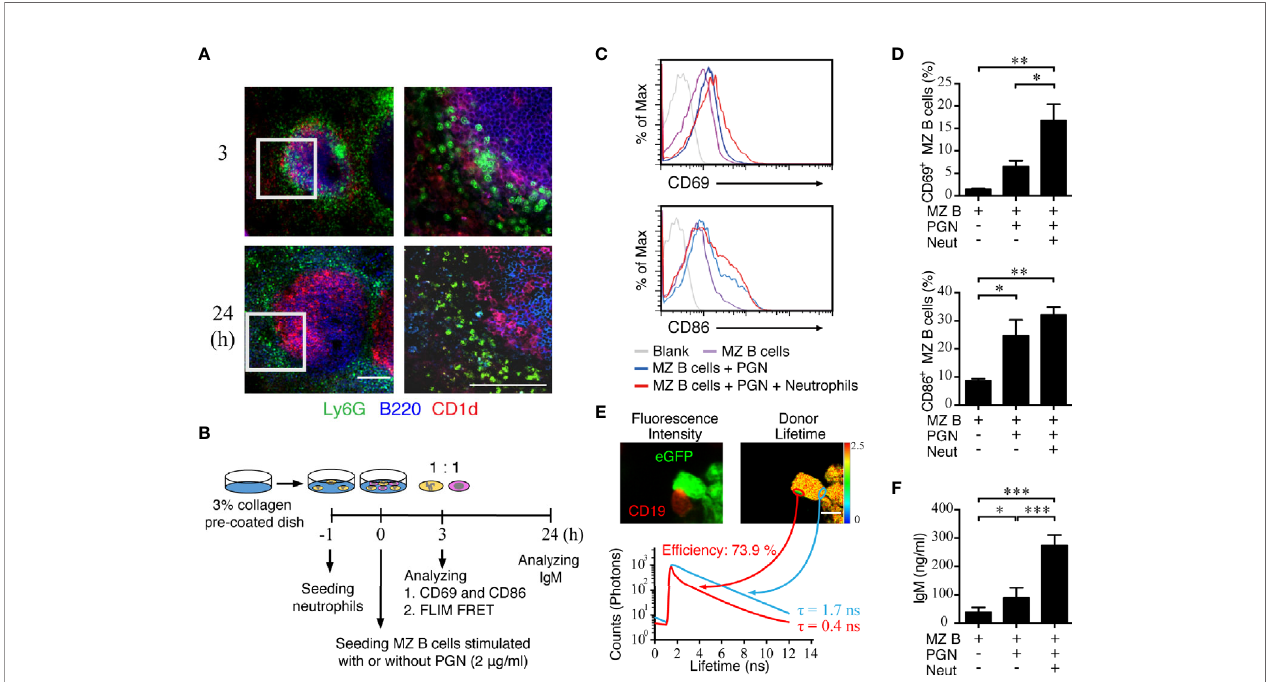
FIGURE 5 | Activation of MZ B cells and IgM production after interaction with neutrophils in S. aureus infection. (A) Confocal microscopy images showing the neutrophils and MZ B cells at 3 h or 24 h after systemic infection with S. aureus (2.5 × 10 6 CFU) in WT mice. Right panels present enlarged images from the boxed areas in the left panels. Scale bar = 100 µm. (B) Schematic diagram showing the experimental design of MZ B cell and neutrophil co-culture experiments. (C) Flow cytometric analysis showing the levels of CD69 (upper panel) and CD86 (lower panel) expression on MZ B cells co-cultured with neutrophils at 3 h after stimulation with PGN (2 µg/ml). (D) Statistical analysis of the percentages of CD69 + (upper panel) or CD86 + (lower panel) MZ B cells co-cultured with neutrophils (Neut) with or without PGN stimulation. (E) The interaction of neutrophils and MZ B cells detected by FLIM FRET analysis. Neutrophils were puri fi ed from LysM-eGFP mice. Sorted MZ B cells were labeled with anti-CD19 primary antibody and Alexa Fluor 546 secondary antibody. The confocal fl uorescence intensity (left panel) and average donor lifetime (right panel) of neutrophils were measured. Lifetime values were pseudocolored according to the color scale. Histograms show the lifetime values of the junction area of neutrophils and MZ B cells (red histogram) as compared with neutrophils only (blue histogram), in a representative experiment. Scale bar = 5 µm. (F) ELISA showing the levels of IgM in supernatants of MZ B cells co-cultured with neutrophils for 24 h with or without PGN stimulation. Results were analyzed by an unpaired t -test. Data are analyzed by one-way ANOVA and presented as the mean ± SEM (n = 4 in D, and n = 6 in F). * p < 0.05, ** p < 0.01 and *** p <